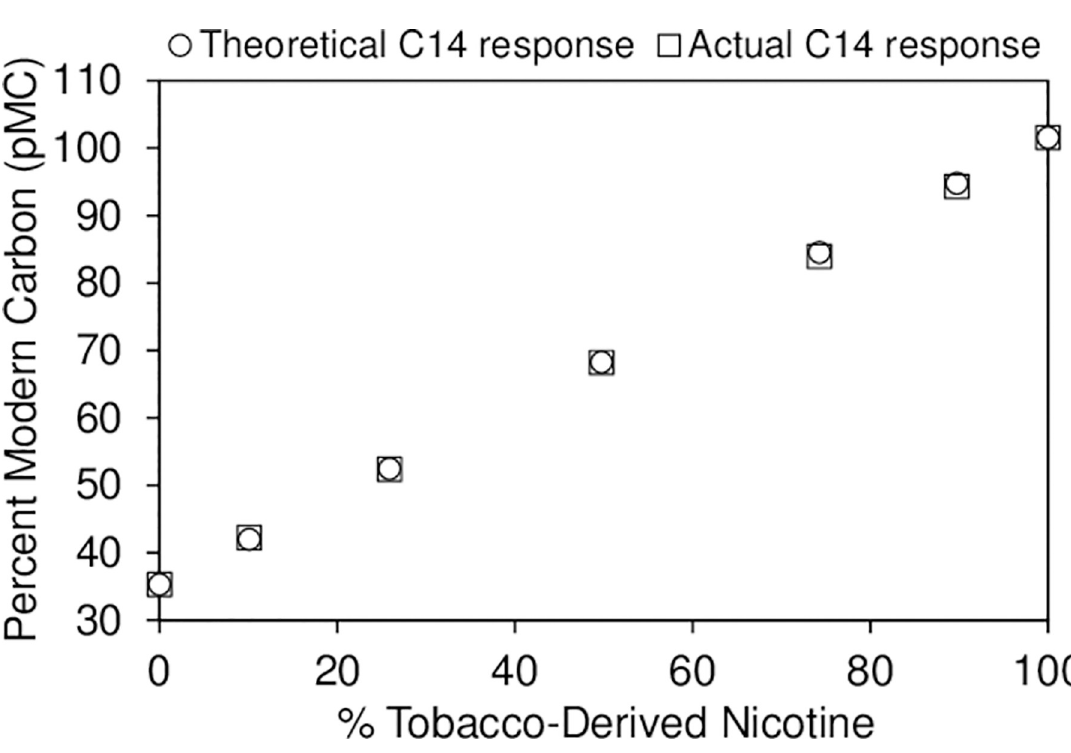
Fig 7. Radiocarbon analysis of blended nicotine mixtures, comparing the observed pMC result to the theoretical value.